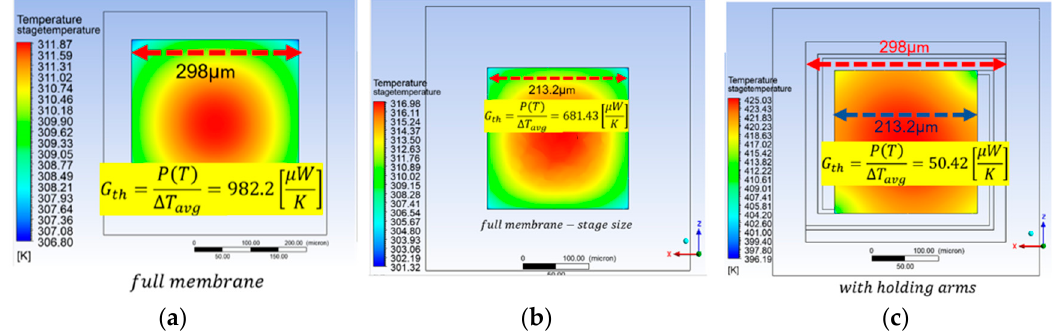
Figure 7. ( a ) Steady state simulation temperature results and G th for: ( a ) full membrane having a pixel size area (298 × 298 µ m 2 ) . ( b ) Full membrane having a stage size area (213 × 213 µ m 2 ) . ( c ) Suspended plate of DUT (pixel size 298 × 298 µ m 2 ; stage size 213 × 213 µ m 2 , holding arms width 6.4 µ m, gap 18 µ m). V heater = 3 V, and R heater = 1000